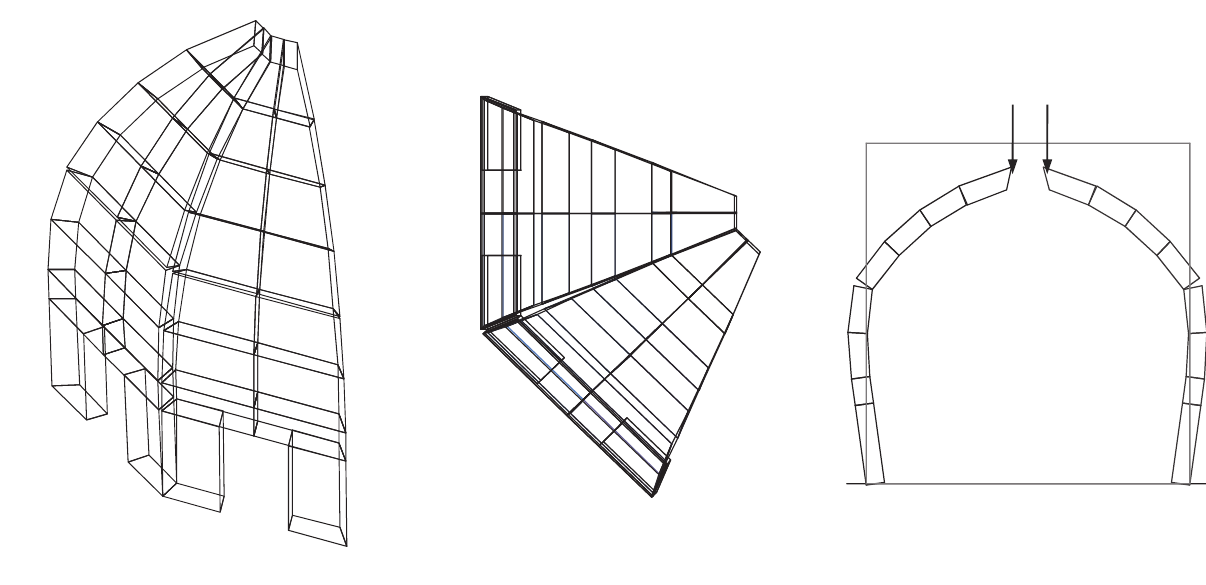
Figure 15: Collapse mechanism for case 7 (failure at ribs / Lf=2 / Nh=0 / sT=1.5 / multiplier α =3.168)